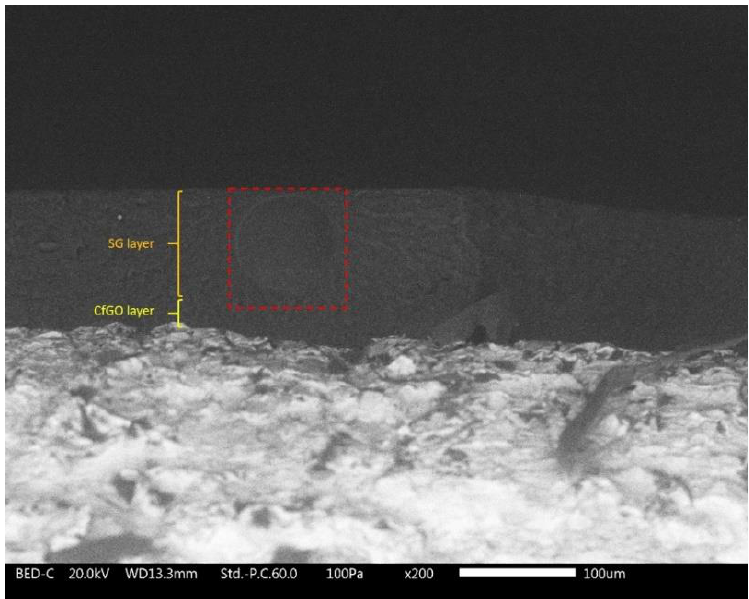
Figure 4. Internal porosity in the SG layer (in the red square), observed with SEM.